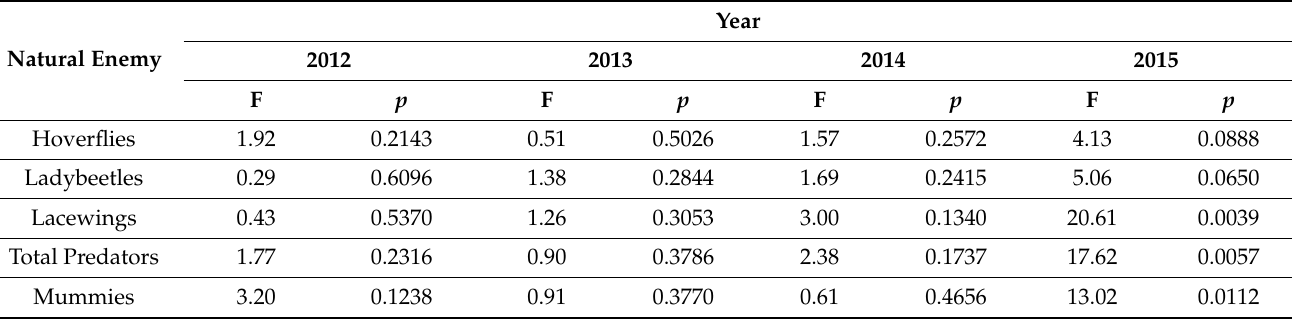
Table 3. F and p values from the ANOVA of repeated measures for the main aphid predators and aphid mummy abundance in each study